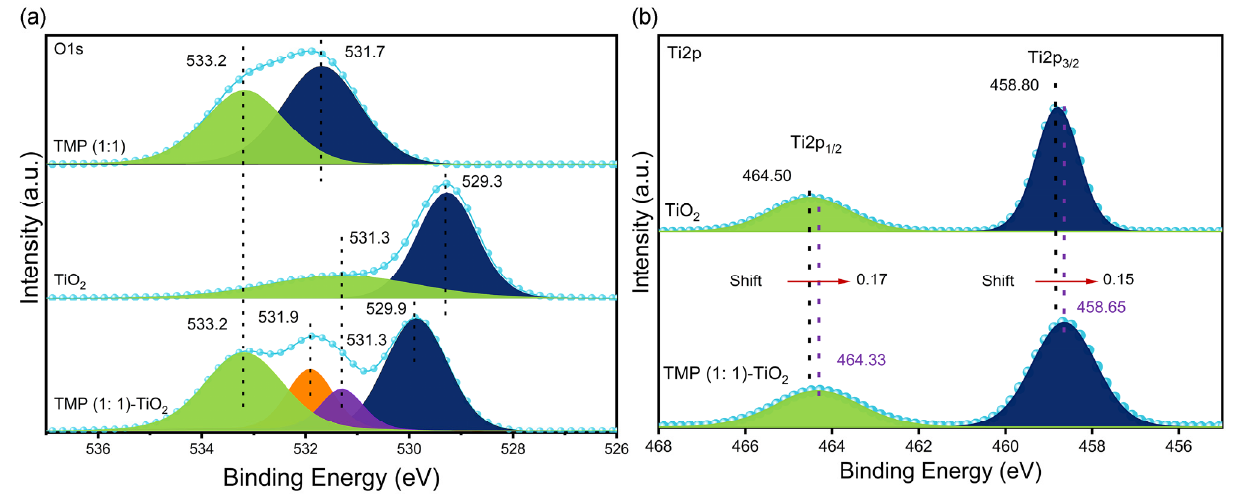
Figure 9. ( a ) XPS O1s spectra of TMP (1:1), TiO 2 , and TMP (1:1)–TiO 2 ; ( b ) XPS Ti2p spectra of TMP (1:1), TiO 2 , and TMP (1:1)–TiO 2 .